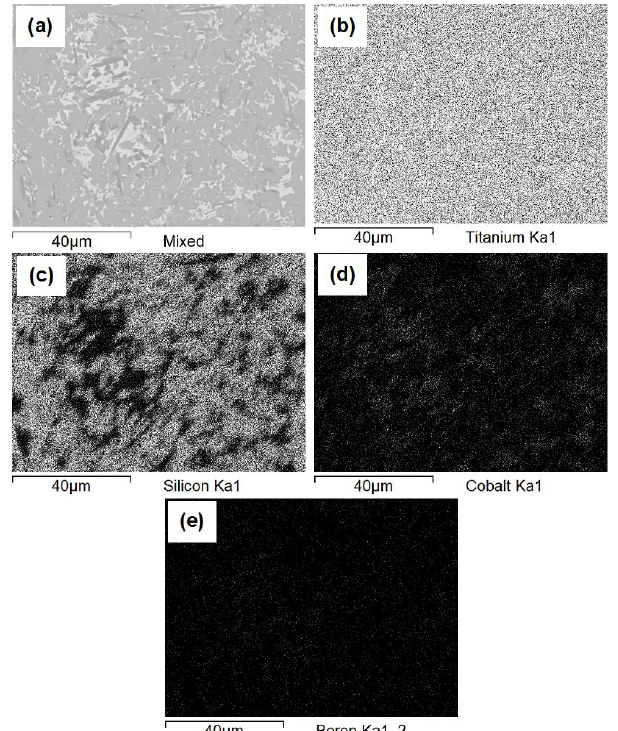
Figure 5. X-ray mapping of the SPSed Ti-6Co-22Si-11B alloy produced with powders milled for 300 min, showing the elemental distribution in its microstructure: (a) pattern, (b) titanium, (c) silicon, (d) cobalt, and (e)